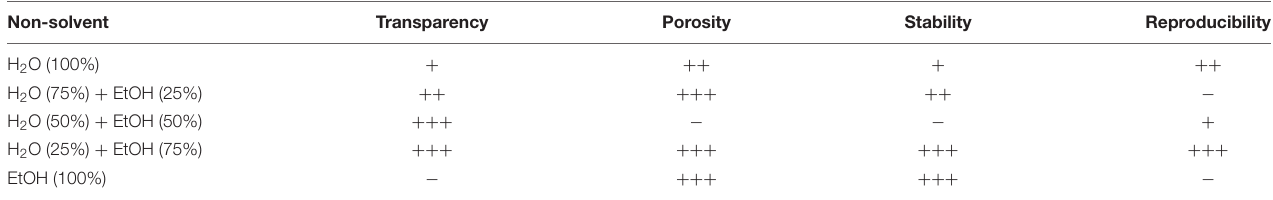
TABLE 1 | Optical transparency, porosity, mechanical integrity, and fabrication reproducibility of CA membranes obtained via vapor-induced phase separation (VIPS) using different non-solvent mixtures. Non-solvent Transparency Porosity Stability